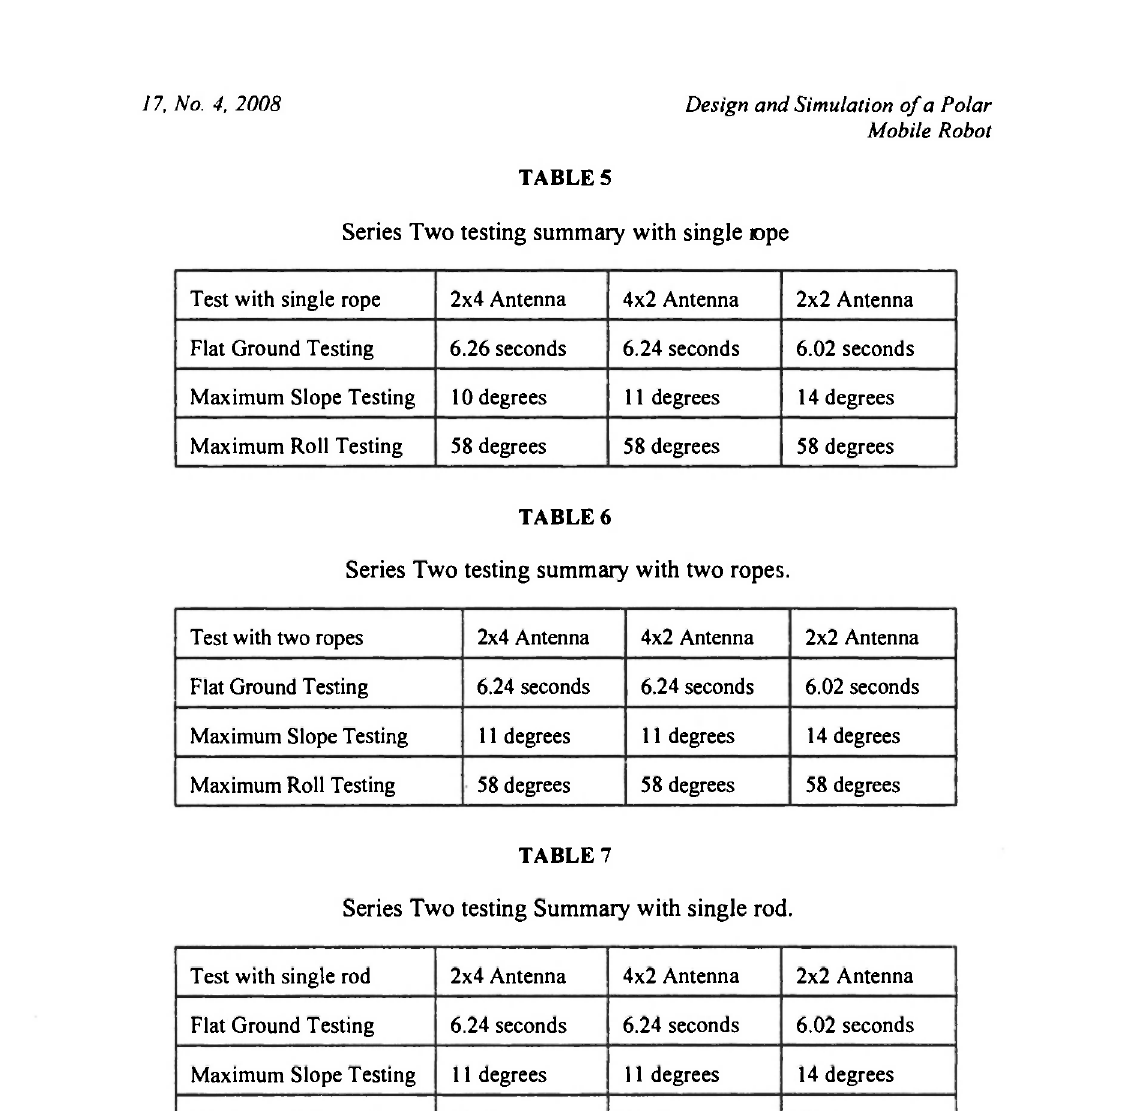
Series Two testing Summary with two